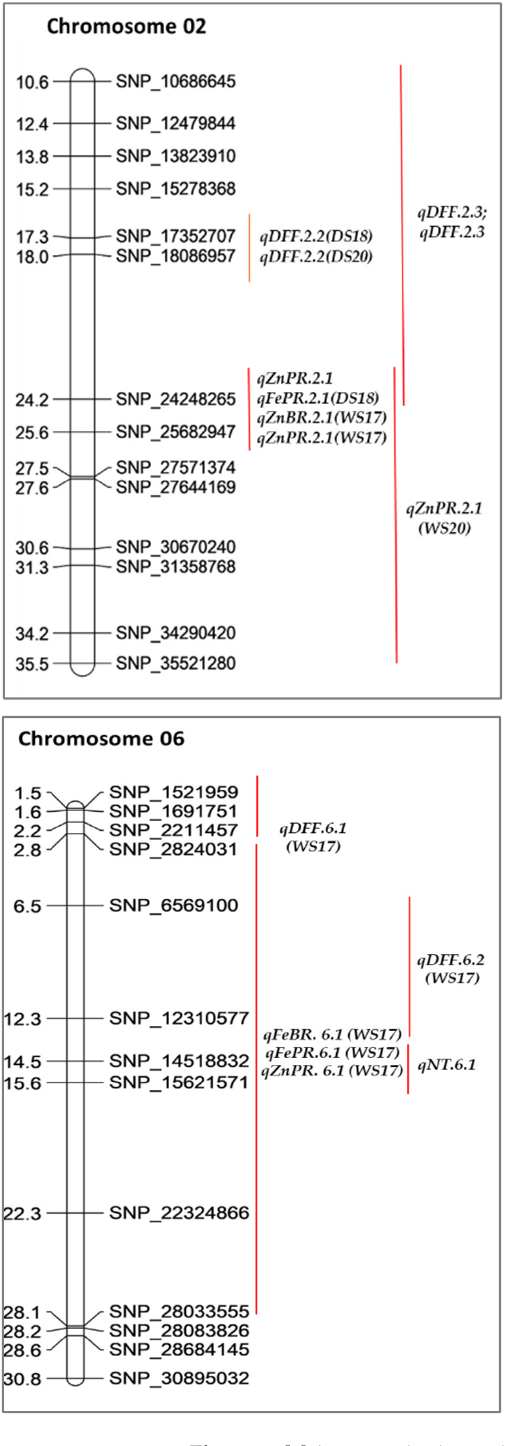
Figure 4. Major quantitative trait loci (QTLs) for various mineral, agronomic, and yield-related traits identified in the MTU1010 X Ranbir Basmati RIL population.